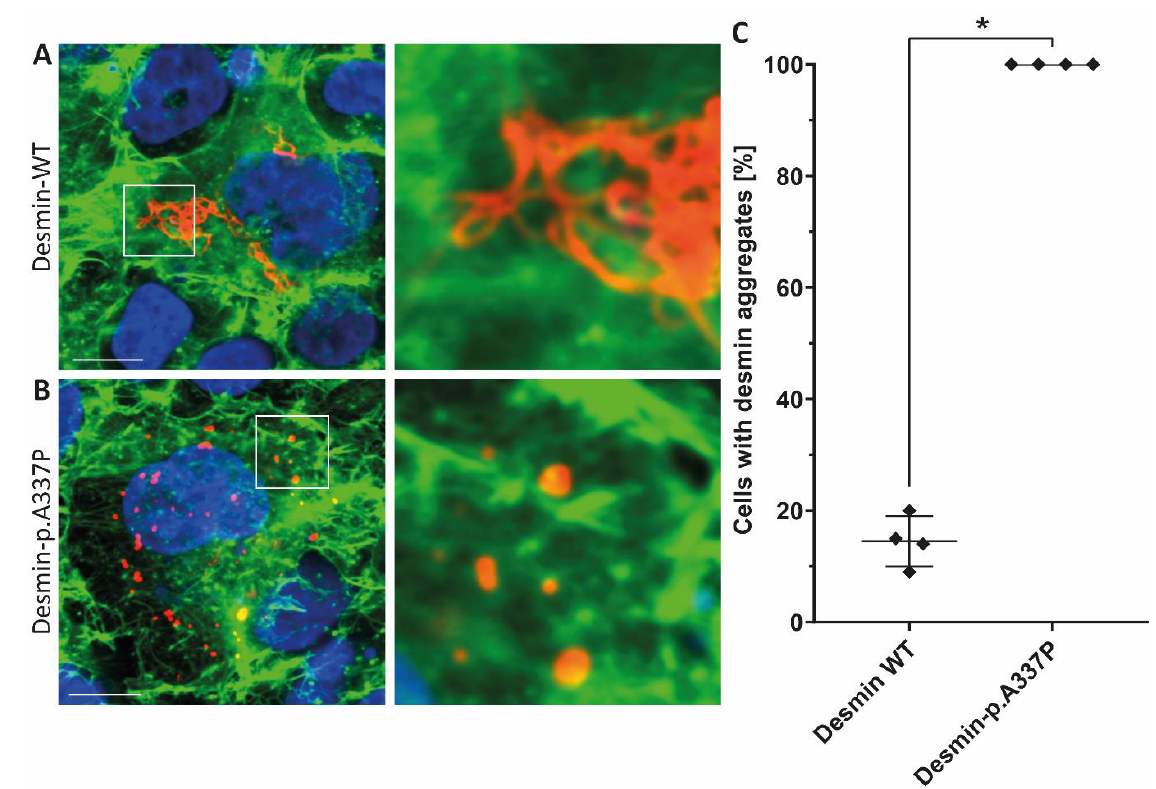
Figure 3. Representative confocal microscopy images of SW-13 cells expressing wild-type desmin ( A ) or desmin-p.A337P ( B ) (shown in red). The fluorescence intensity of Alexa-488 conjugated to phalloidin (for F-actin staining) is shown in green and the nuclei were stained using DAPI (blue). Scale bars represent 10 µm. ( C ) Statistical analysis of desmin aggregate formation revealed for desmin-p.A337P an abnormal cytoplasmic aggregate formation in the majority of transfected SW-13 cells. * p -value < 0.05.